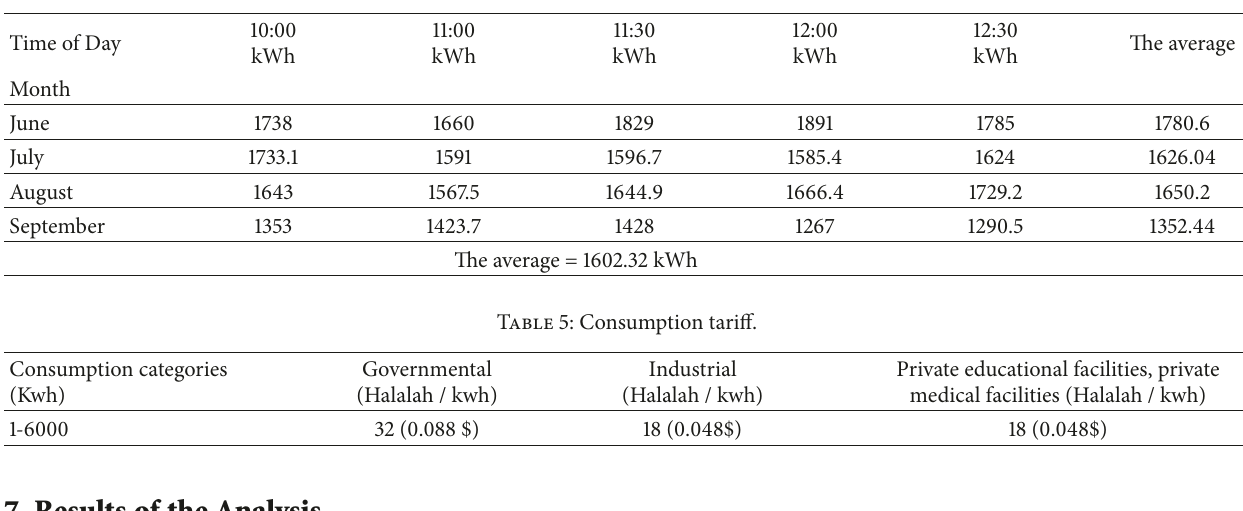
Table 4: Energy consumption over 9 months for room 802.